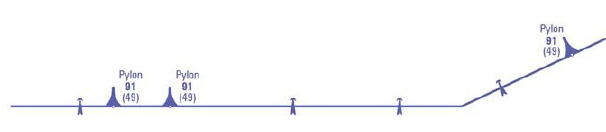
Fig. 2. Power line pylons as aeronautical obstacles